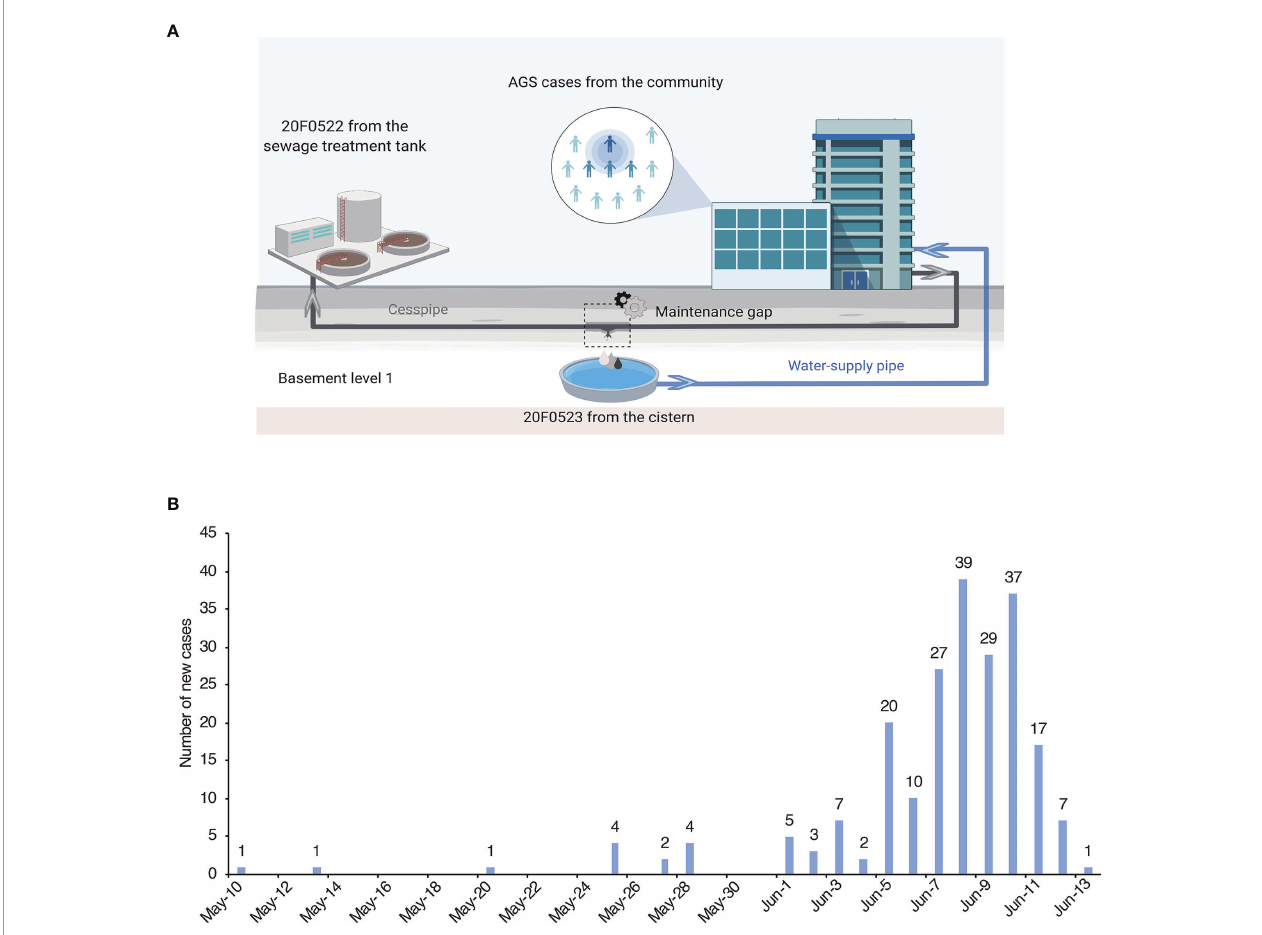
FIGURE 2 | Samples collection locations and daily number of new cases. (A) The location of cases and water samples. The cesspipe is parallel over the water supply pipe, and there is a maintenance gap near the reservoir in the basement level 1. (B) Daily number of new cases of the epidemic in Guangdong, China during